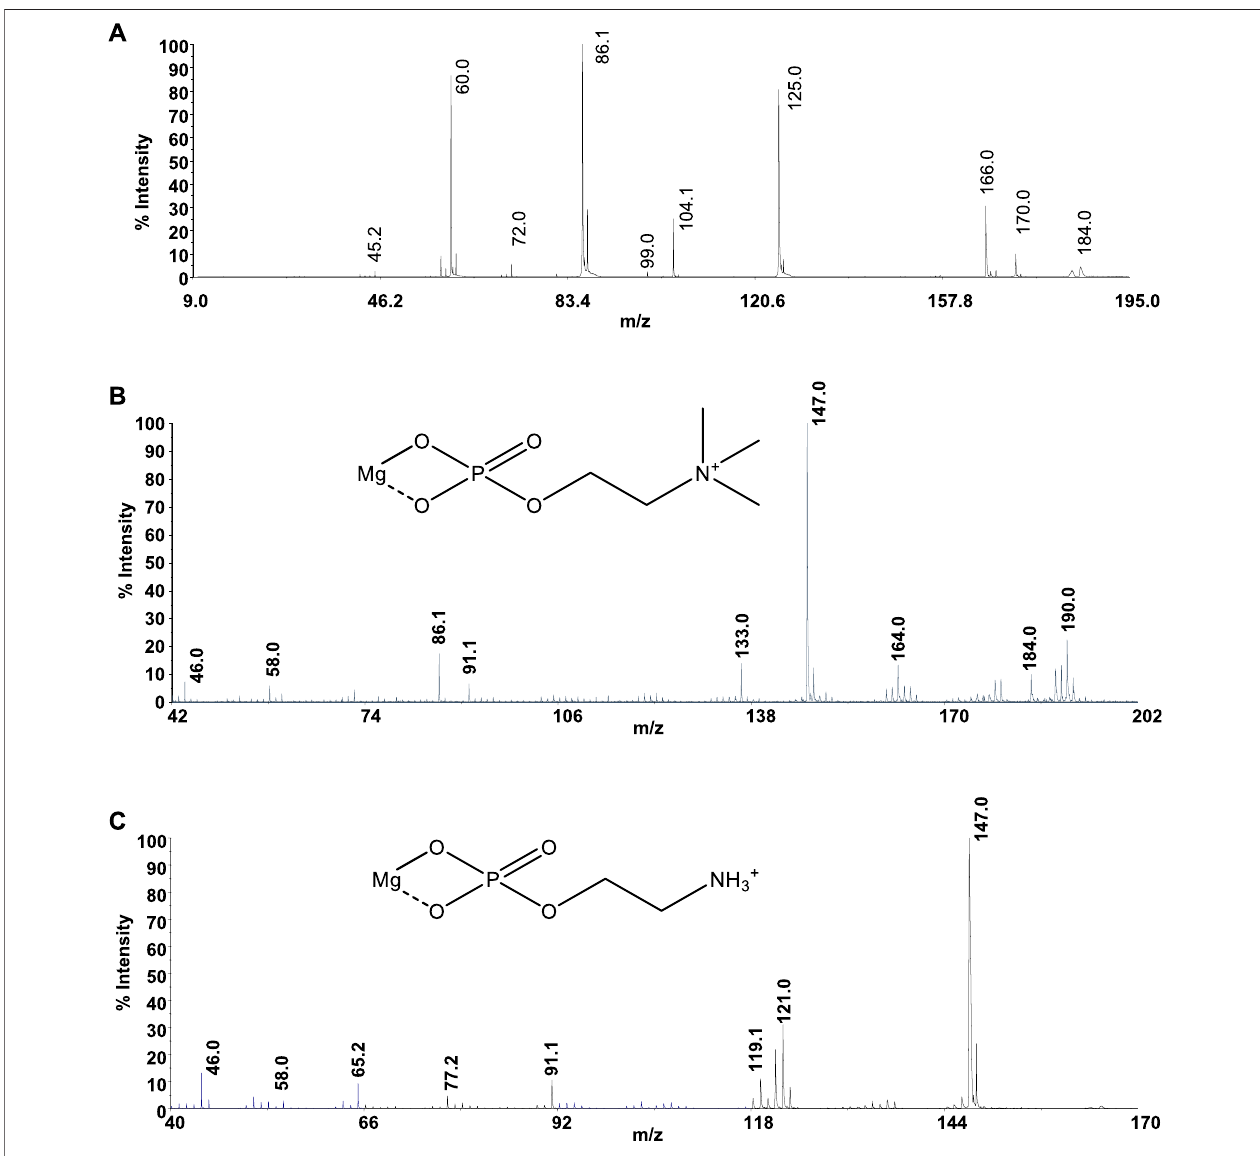
FIGURE 8 | Product-ion spectra of (A) [ PPC ] + , (B) [Mg PPC ] + , and (C) [Mg PEA ] + .